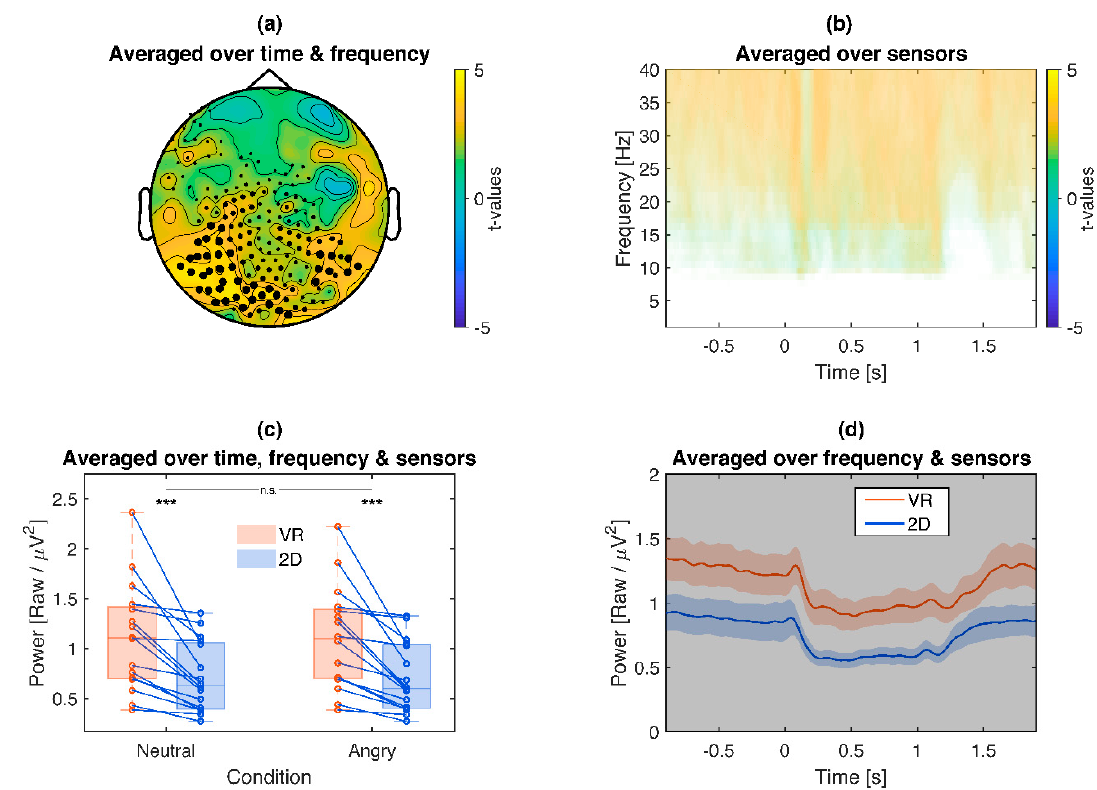
Figure 7. Illustration of the VR vs. 2D frequency cluster (raw power without baseline correction): VR leads to overall more high frequency power both in pre- and post-stimulus time periods. (a): Topography of t -values averaged across the significant time points and frequency bins. (b) : Time-frequency plot of t -values, averaged across sensors of the respective cluster. Only time-frequency bins which are part of the cluster are displayed. (c): Box plot and single subject values from the cluster. Blue lines indicate more high frequency power for VR compared to 2D conditions, red the opposite. Asterisks indicate the significance of exploratory post-hoc group comparisons: *** p < 0.001, ns p > 0.05. (d): Time course of the cluster. Colored shaded areas signify standard errors. Grey shaded areas signify the latency of the cluster.